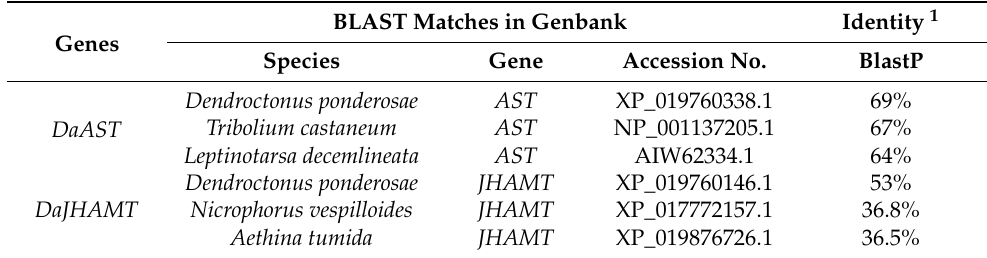
Table 1. Amino acid identity of putative allatostatin ( DaAST ) and juvenile hormone acid O- methyltransferase ( DaJHAMT ) with related sequences in other insect species.